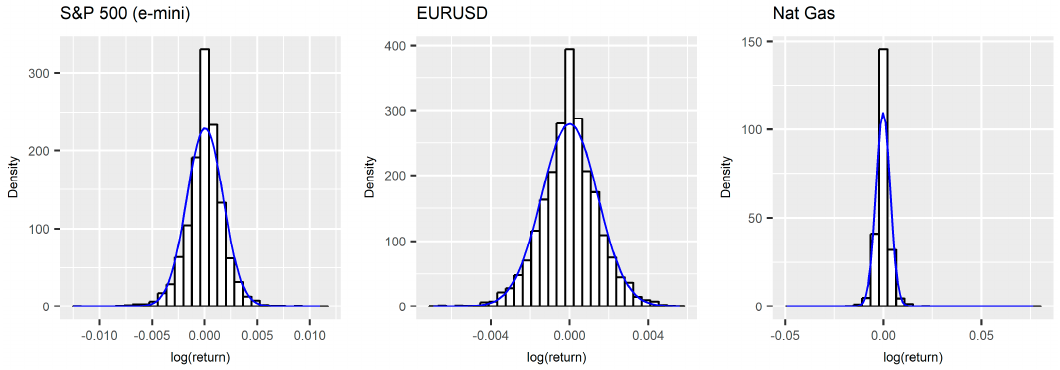
Figure 2. Second stylized fact.